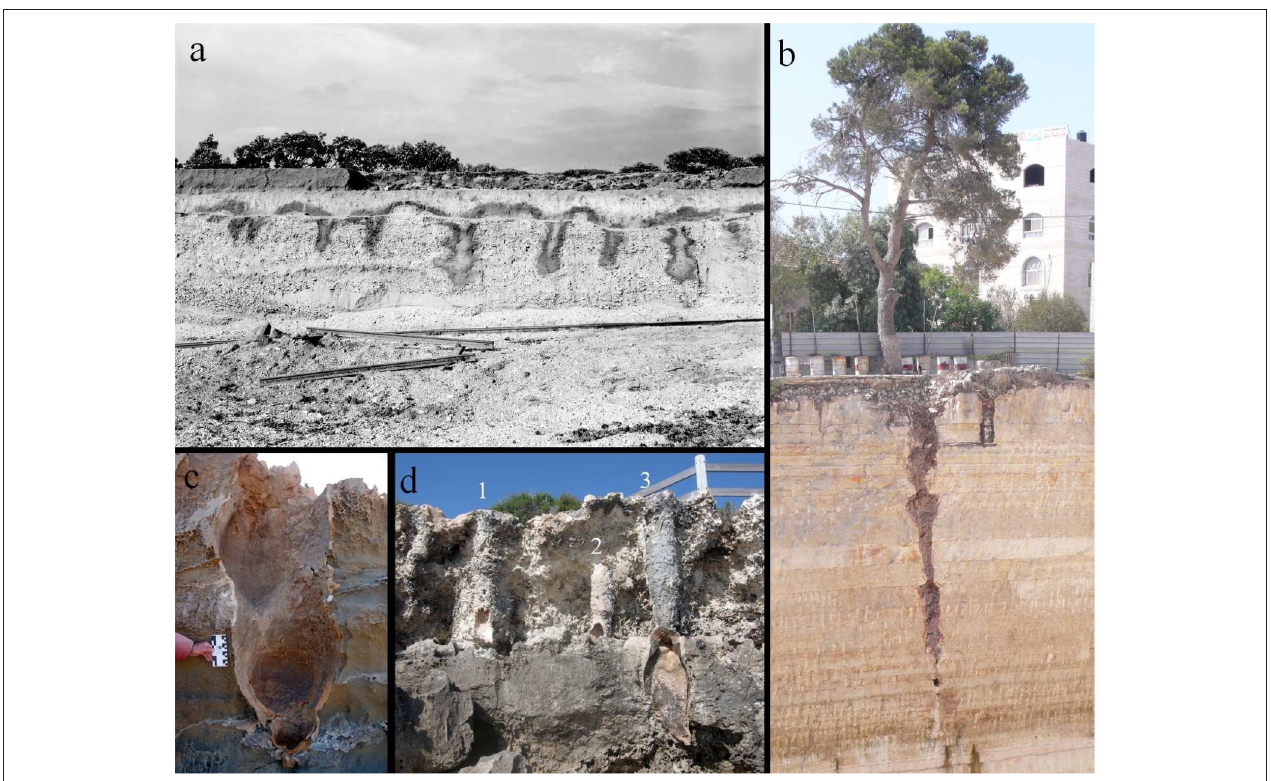
FIGURE 1 | Examples of the solution pipe morphologies in stratified systems. (A) Solution pipes in gravel with limestone clasts: gravel-pit, west of Rauceby Station, UK. Photo by J. Rhodes courtesy British Geological Survey (catalog no. P206264). (B) Solution pipe in Ramallah, Israel, cutting through stratified dolomites with marl beds. The photograph is courtesy of Sebastian Schmidt of University of Göttingen. (C) Solution pipe cutting through layered limestone rock at Cape Bridgewater, Victoria, Australia (D) three pipes with cemented rims in limestone formations at Burns Beach, Perth, Australia. Pipe no. 3 cuts through the more resistant bed in the lower portion of the